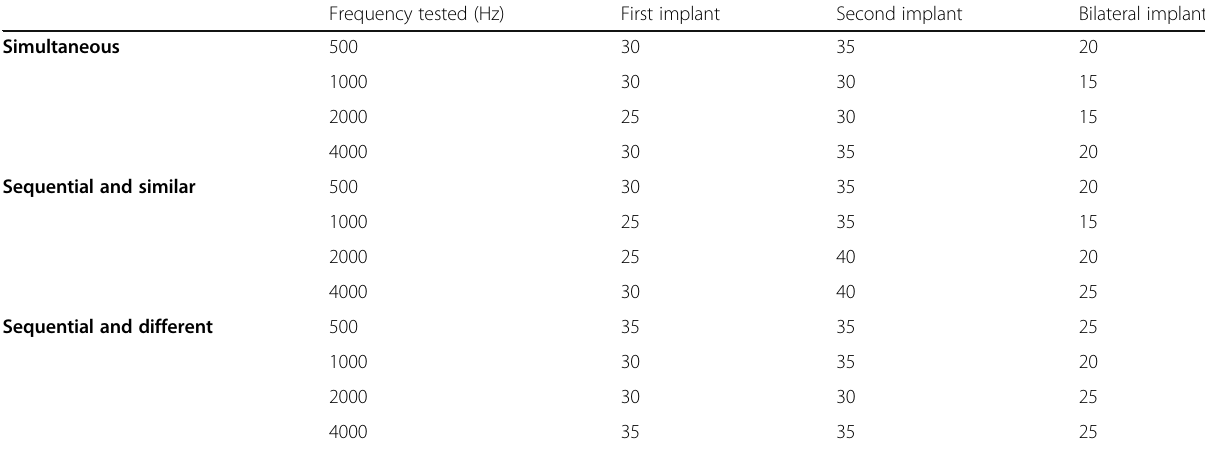
Table 3 Aided threshold 6 months after bilateral implantation